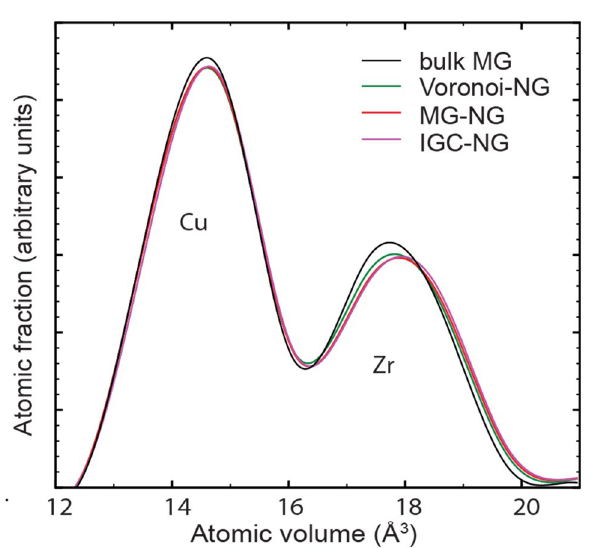
IGC-NG models indicate a prominent deviation from the curve of bulk MG, especially for the atomic volume of Zr. For the IGC-NG, Cu and Zr curves both show a positive deviation from the bulk MG for layers 6 and 7. That indicates the source of the excess free volume at interfaces, which are distributed along the layers 6 and 7, i.e., within a 1 nm thick layer from the original surface of the nanoparticles. As shown in Fig. 3 after consolida- tion the layers 6 and 7 form an irregular shaped volume that connects the glassy grain cores, which contain a relatively unaffected amorphous structure.